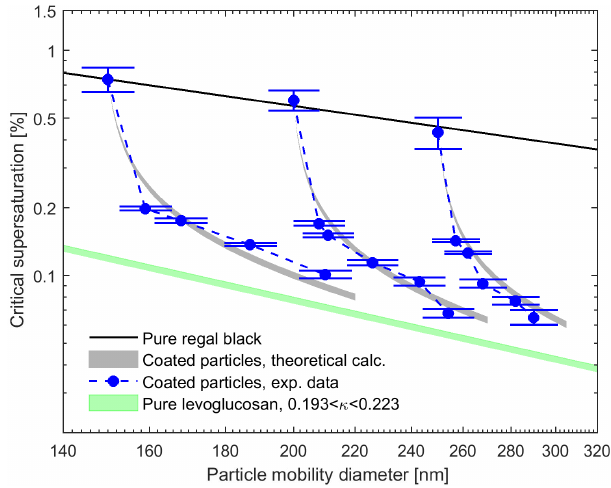
Figure 6. Experimental and theoretical critical supersaturations for BC particles coated by levoglucosan for different particle mobility diameters. The black line represents the calculated critical super- saturations of the pure BC particles using the FHH adsorption ac- tivation theory (Eq. 10). The gray shaded areas define the critical supersaturations calculated using Eq. (9) and variety of the κ val- ues reported in the literature for levoglucosan (see Table 1). The green shaded area represents the critical supersaturations from the κ -Köhler theory (Petters and Kreidenweis, 2007) for the pure lev- oglucosan particles with the range of κ values from literature. Error bars represent the experimental uncertainty in the critical supersat- uration s c corresponding to each mobility diameter.